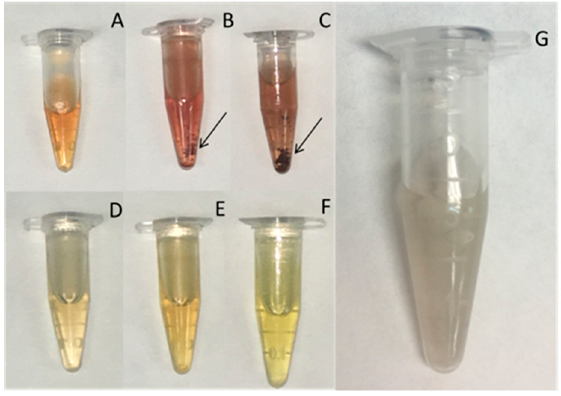
Figure 1. Visual evaluation of AgNp-polymer solutions after 5 h at 90 °C (day 0). ( A ) F1Q, ( B ) F2Q, ( C ) F3Q, ( D ) F1L, ( E ) F2L, ( F ) F3L, and ( G ) parent chitosan. Arrows indicate the presence of aggregates.